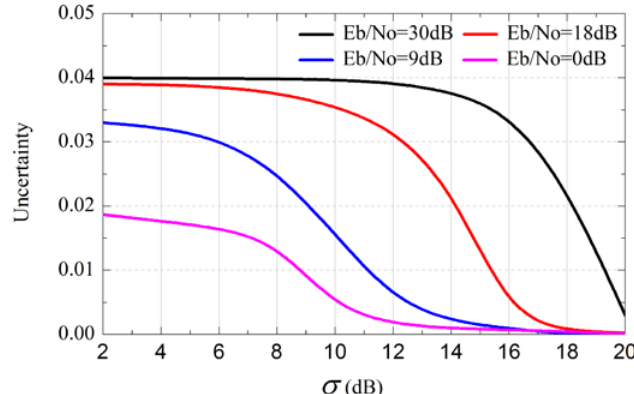
Figure 8. The relationship between uncertainty and shadowing standard deviation.